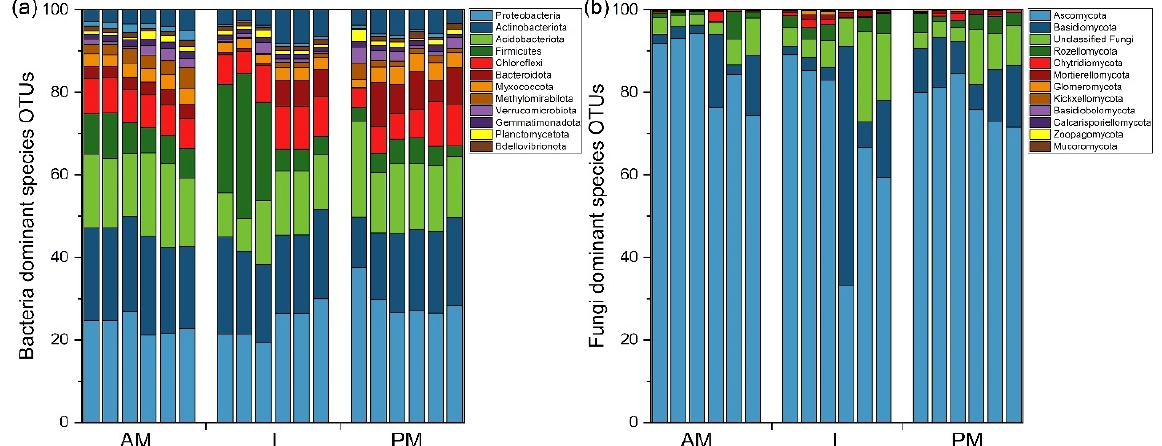
Figure 4. Soil microbial community composition under different planting patterns (a-bacteria, b-fungi). The abundance of each taxon was calculated as the percentage of sequences per gradient for a given microbial group. AM represents areca nut monocropping; I represents areca nut intercropping with pandan; and PM represents pandan monocropping.